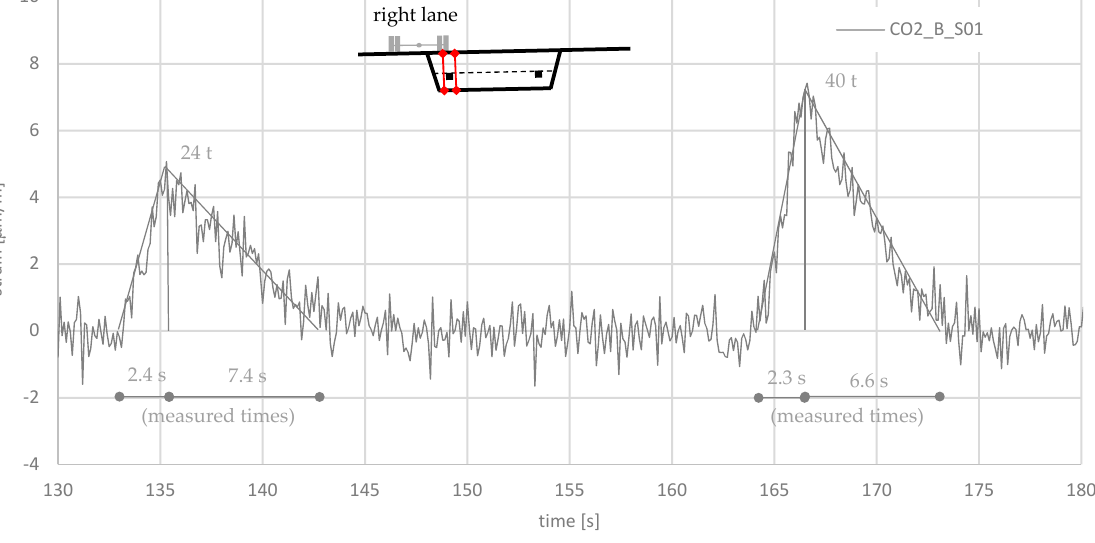
Figure 9. Strain measurement of the reference trucks, where after the 24 ton truck, the 40 ton truck followed.